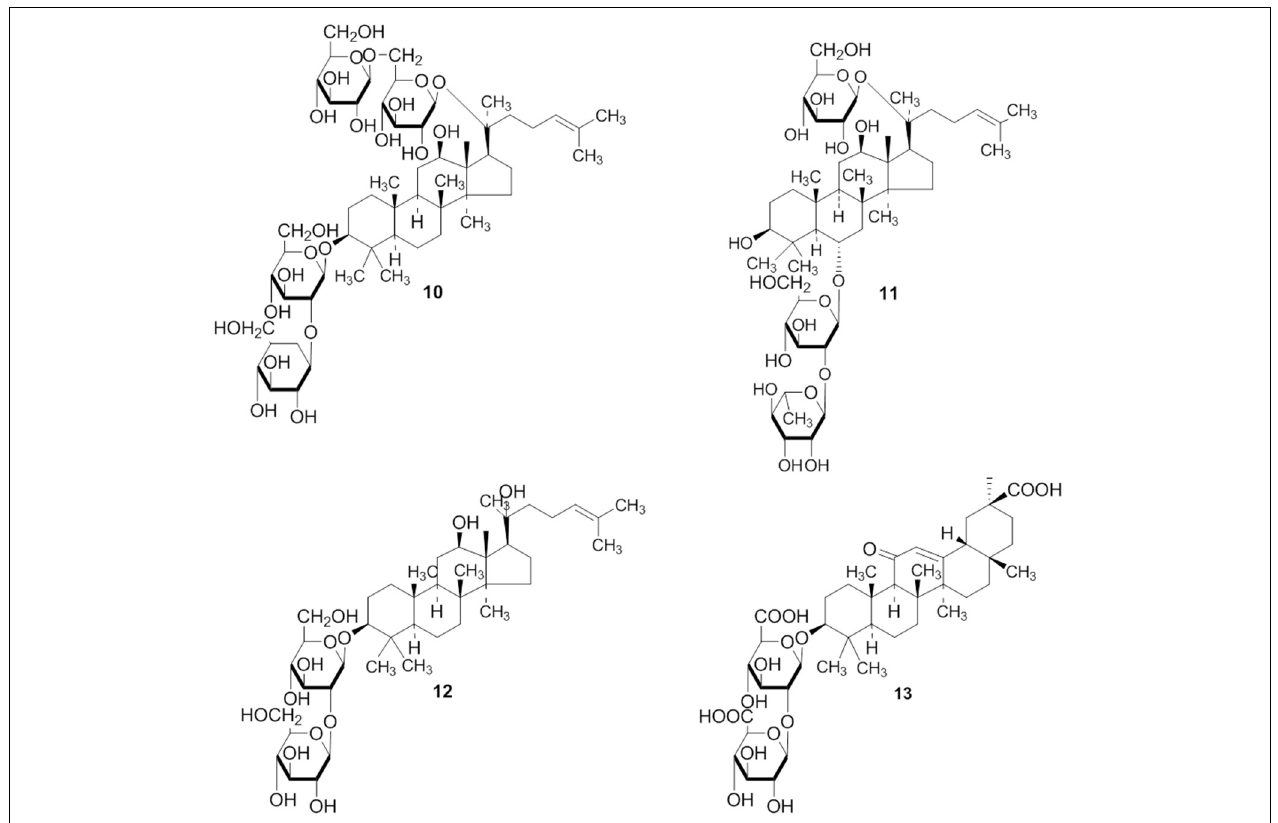
FIGURE 4 | The structure of 10 is corrected.